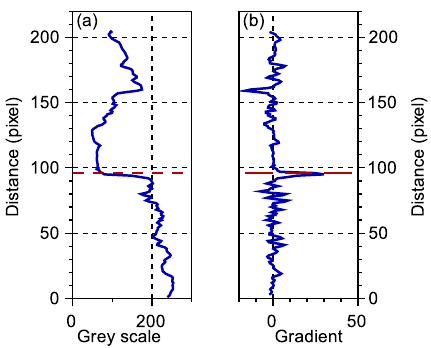
Figure 7. Grey-scale profiles for water surface measurement. (a) The first stage board on the right side of the stream, (b) the second stage board on the left side of the river and (c) on-boulder vertical surface. The red and blue lines show two different water elevations days apart.